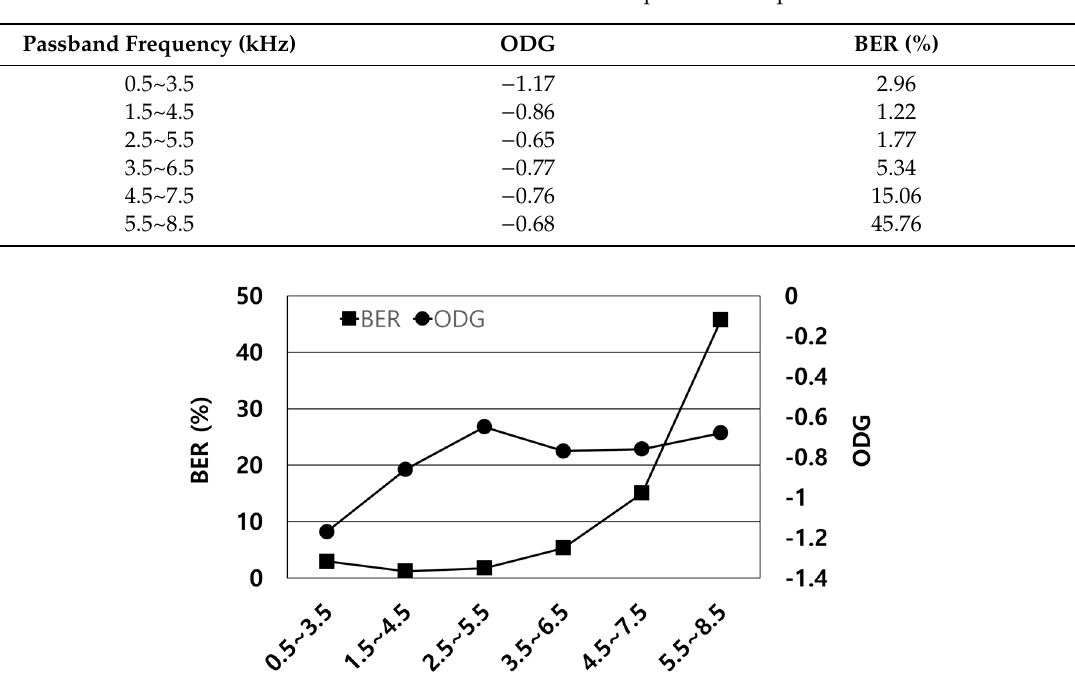
Table 3. ODG and BER values under various passband frequencies.